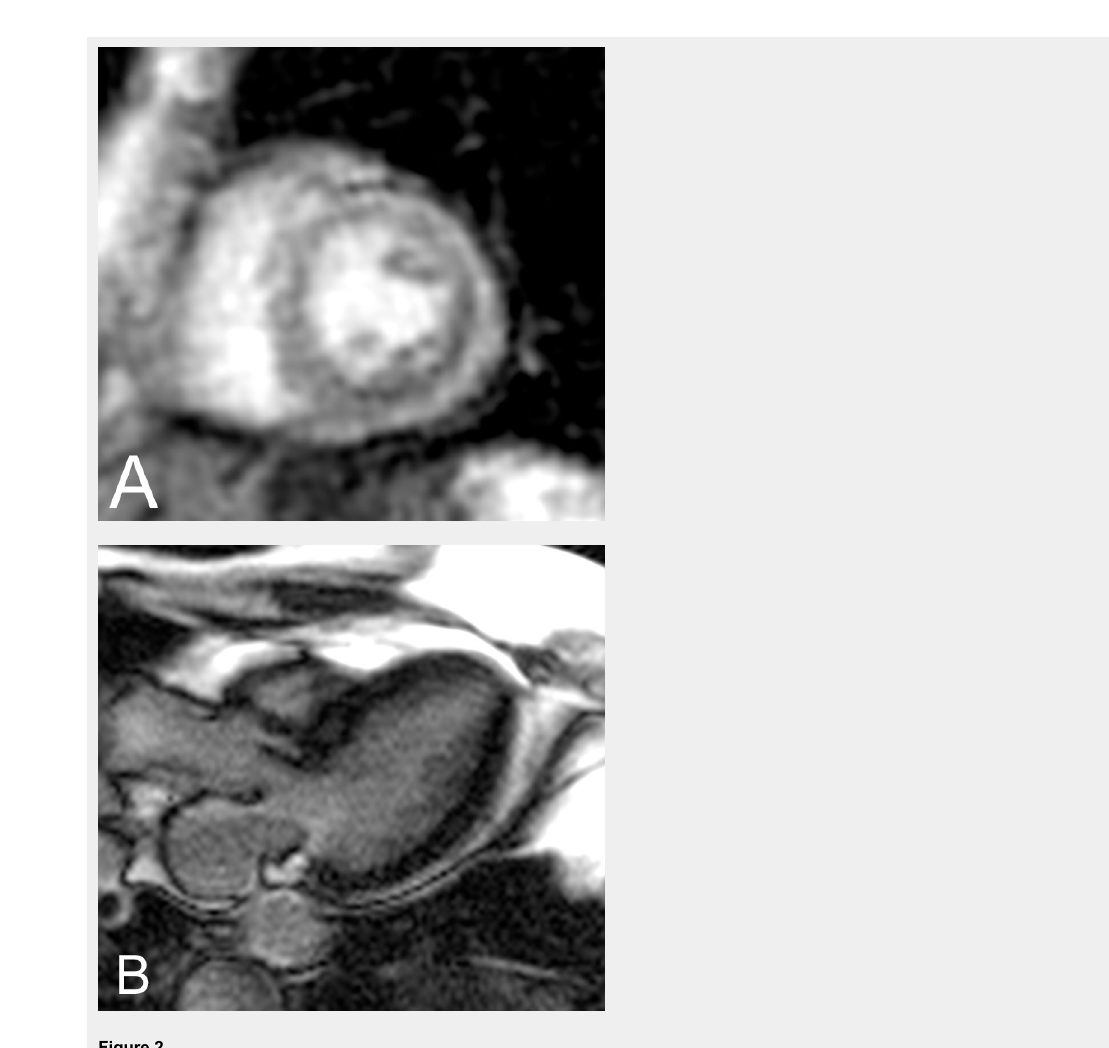
Figure 2 CMR and DE-CMR images. Fig. 2A: Short axis view of left ventricular myocardium without contrast showing an aspecific hypocaptation in the infero-basal portion. Fig. 2B: Long-axis DE-CMR images showing no late